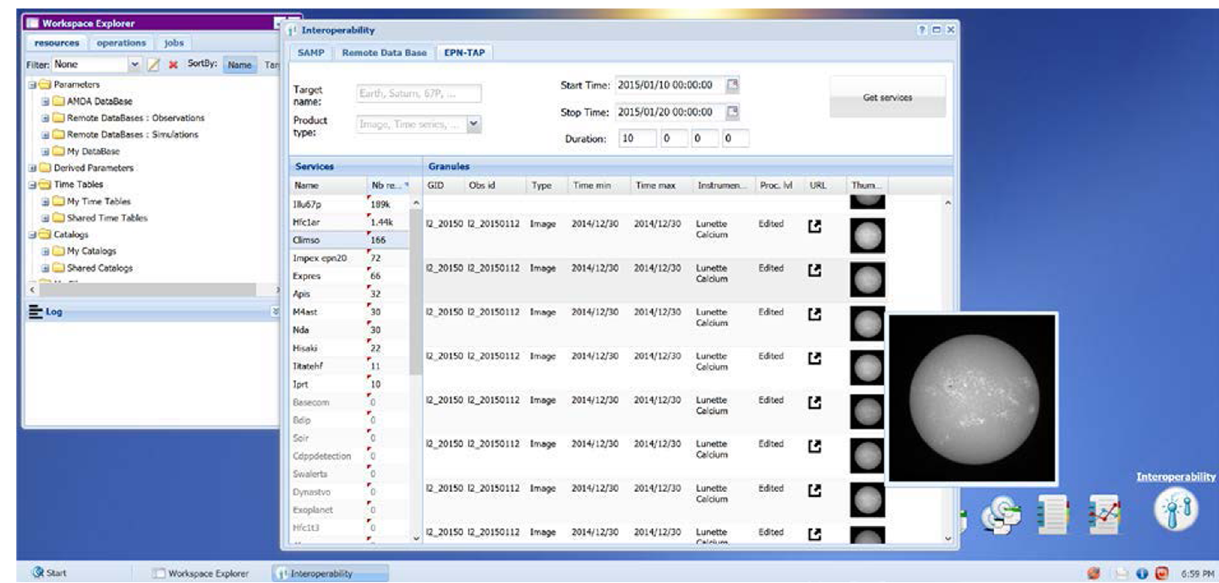
Fig. 12. CLIMSO archive visible and accessible from AMDA through EPN-TAP web